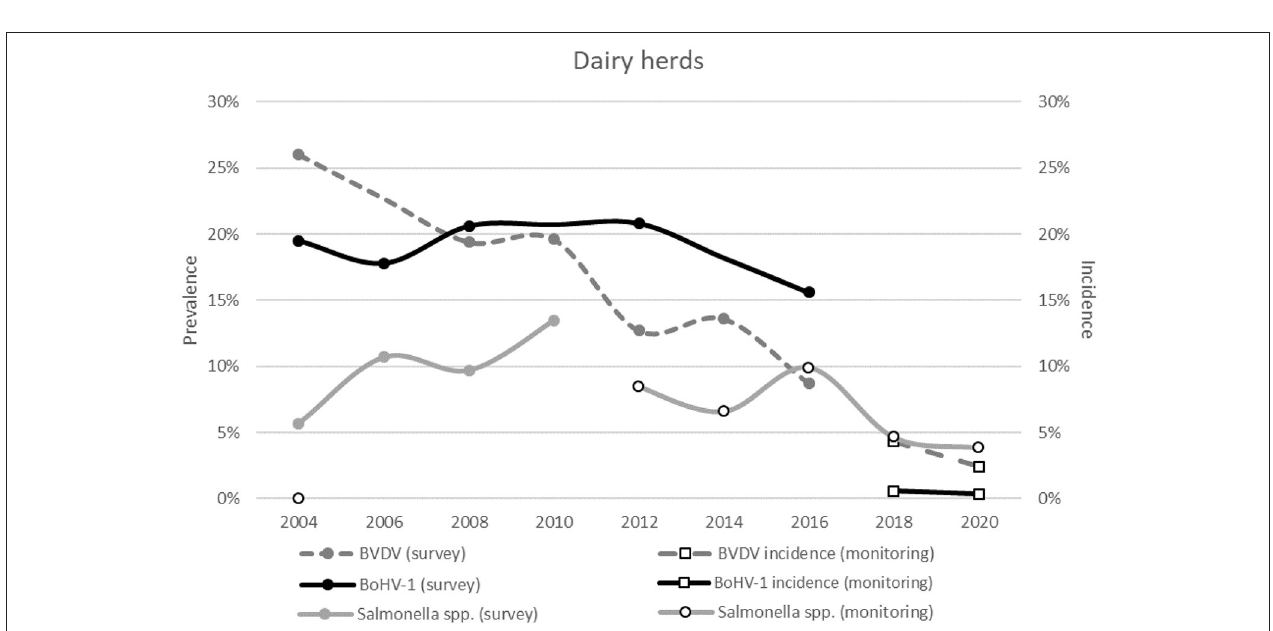
FIGURE 9 | Dutch suckler herds that voluntarily participate in a CP for BoHV-1, BVDV or L . Hardjo and have a free status between 2009 and 2019.